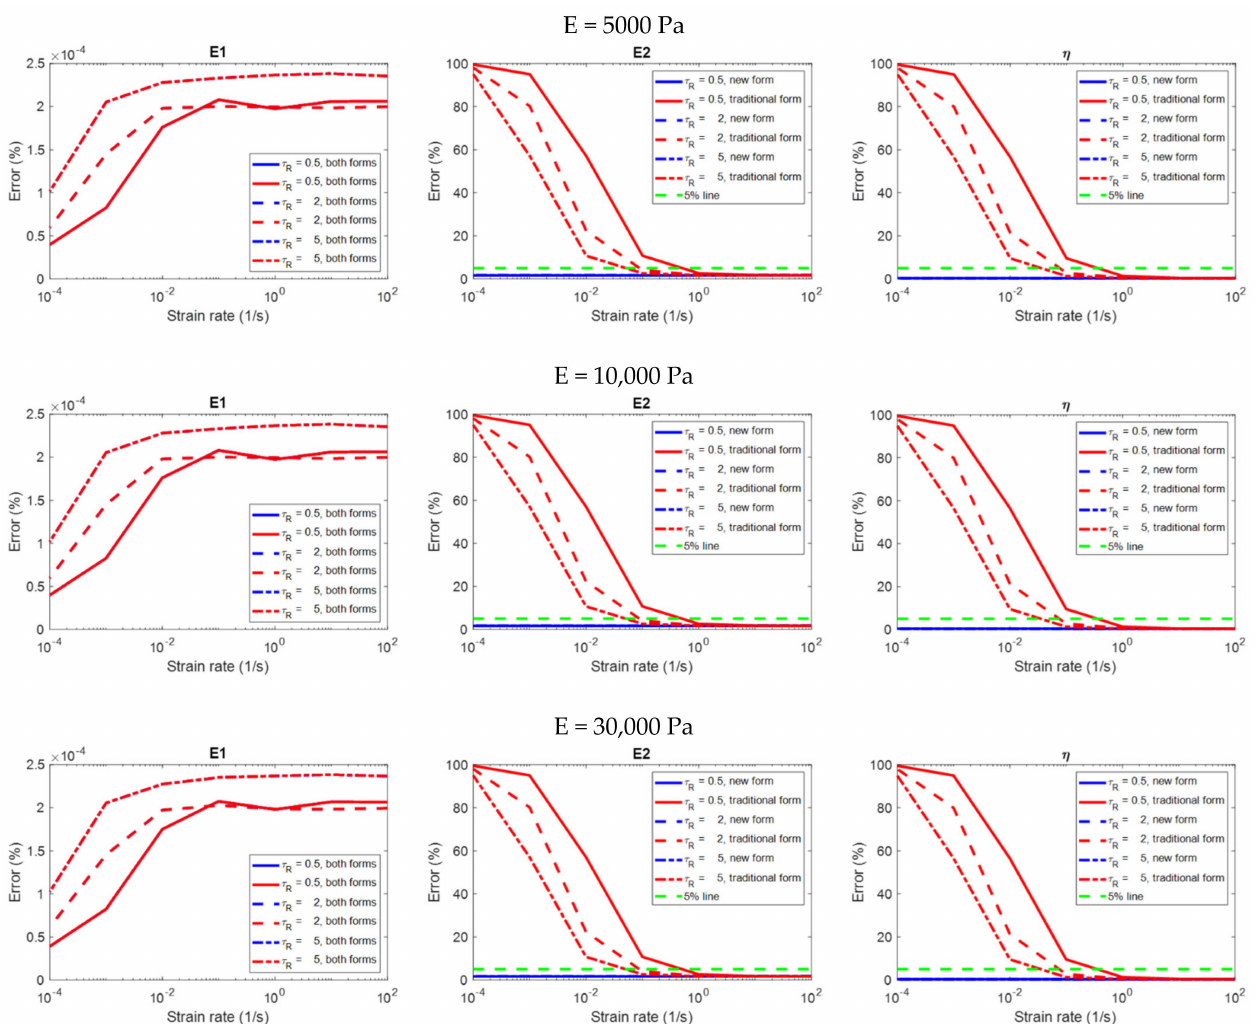
Figure 6. The relationship between the strain rate and the error in the evaluation of the viscoelastic properties on different material models in the stress relaxation simulation, analyzed using the two constitutive equation forms (i.e., the newly − introduced form derived with finite loading rate, and the traditional form derived with infinite loading